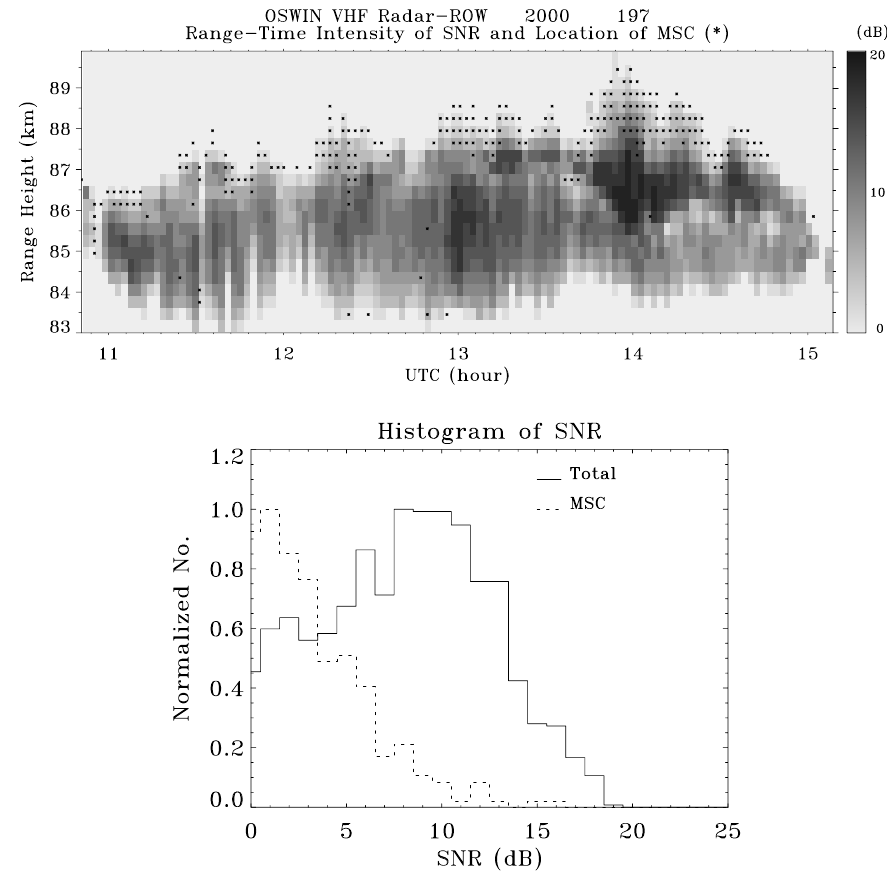
Fig. 5. Same as Fig. 3, but with a 16-s time resolution and for the ROW data (1024 points).